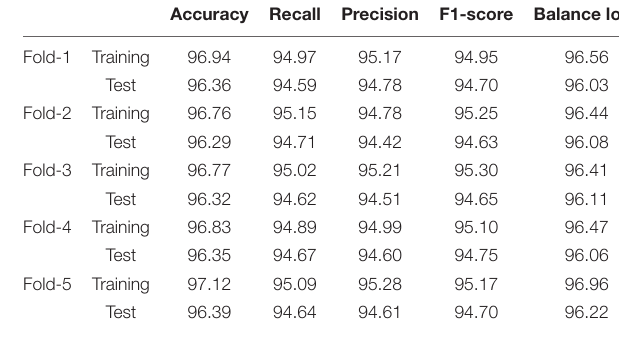
TABLE 2 | Classification performance of CDLLC on the Cheng